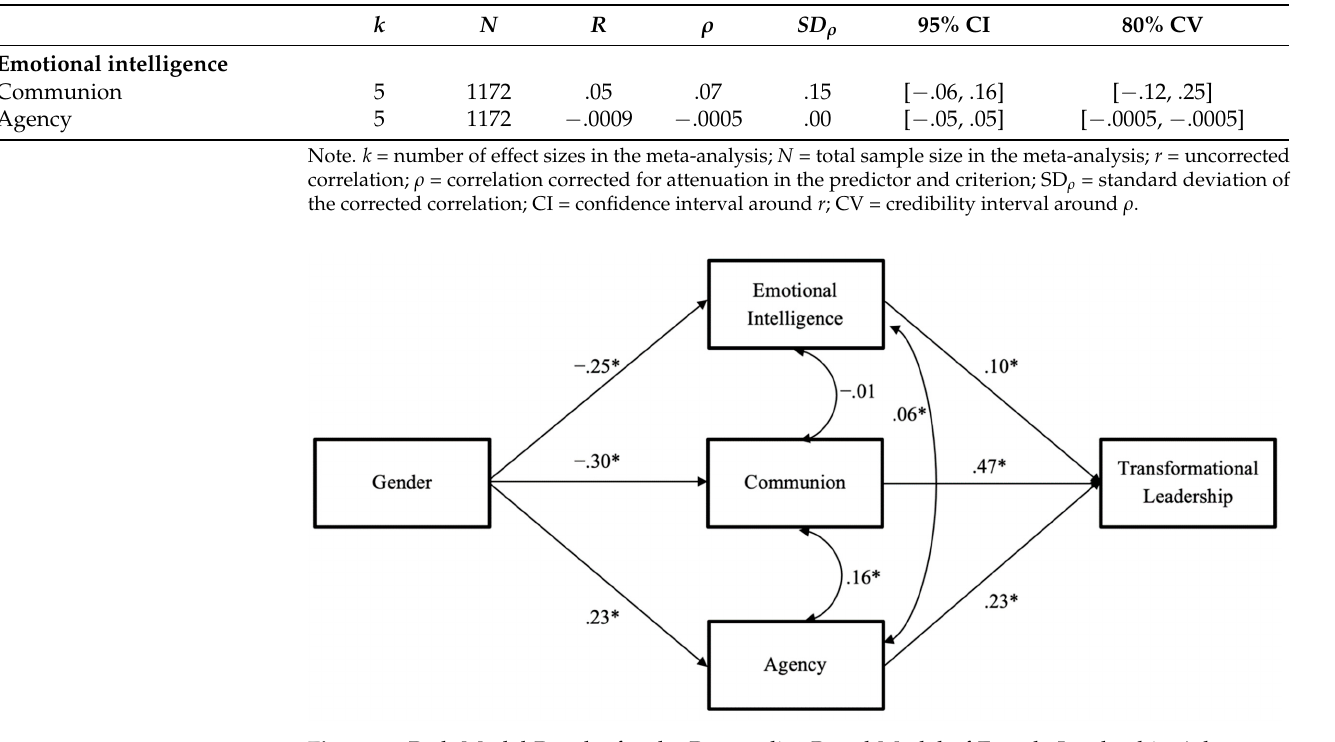
Figure 3. Path Model Results for the Personality-Based Model of Female Leadership Advantage (Model 1a). Note. Standardized path coefficients ( β ’ s) are presented. N = 420; χ 2 (1) = .434; RMSEA = .000, CFI = 1.000; NNFI = 1.023; SRMR = .006; * p < .05. Transformational leadership non-self-reported. Female = 1, Male =